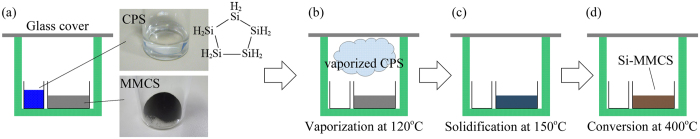
Schematic of the LVD process using CPS: (a) CPS and MMCS are placed in a deposition chamber away from each other; (b) CPS is vaporized at 120 °C; (c) CPS adsorbed onto MMCS solidifies via a cross-linking reaction at 150 °C; and (d) cross-linked CPS is transformed into solid silicon via thermal decomposition at 400 °C.